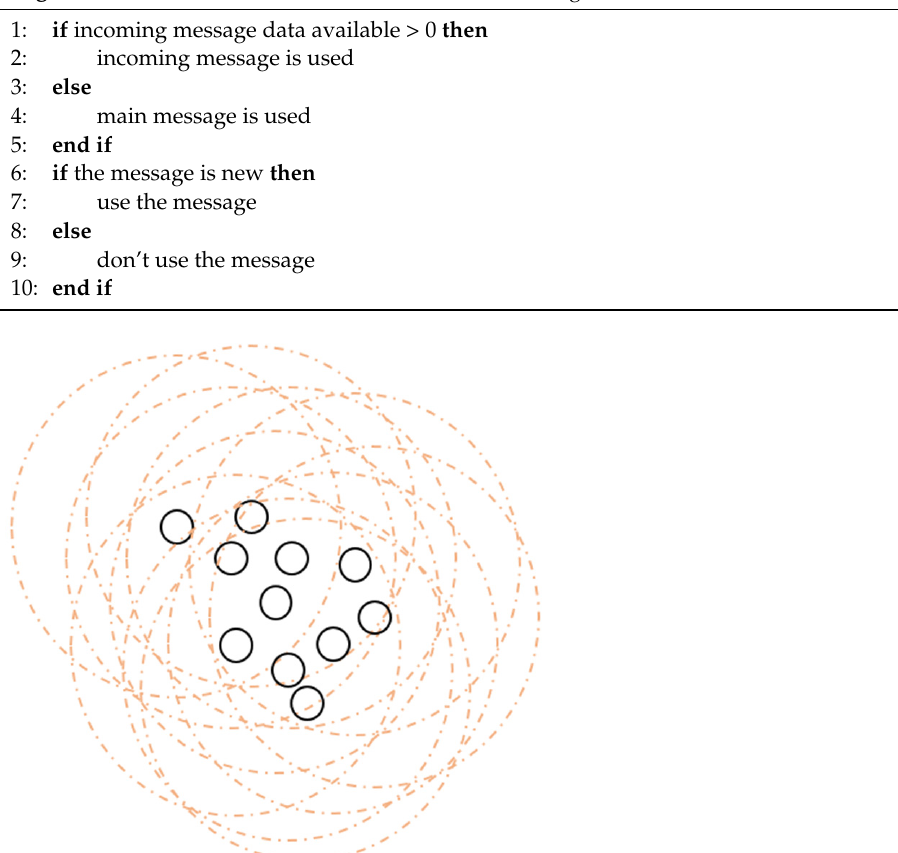
Algorithm 7 Solution: Communication distance is too high